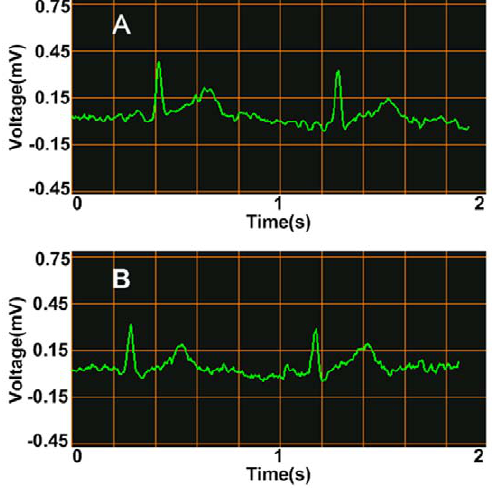
Figure 4. ECG test and results on a rabbit with normal and liquid metal electrode. (A) ECG test on a rabbit; (B) Results using button electrode; (C) Results using liquid metal electrode.